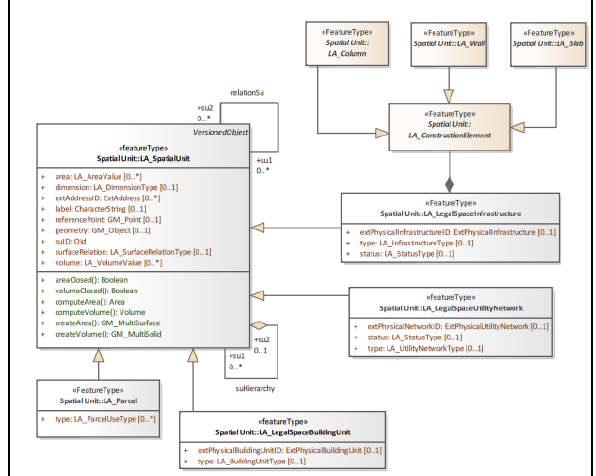
Figure 9. Proposed ‘LA_LegalSpaceInfrastructure’ class supporting IFC for